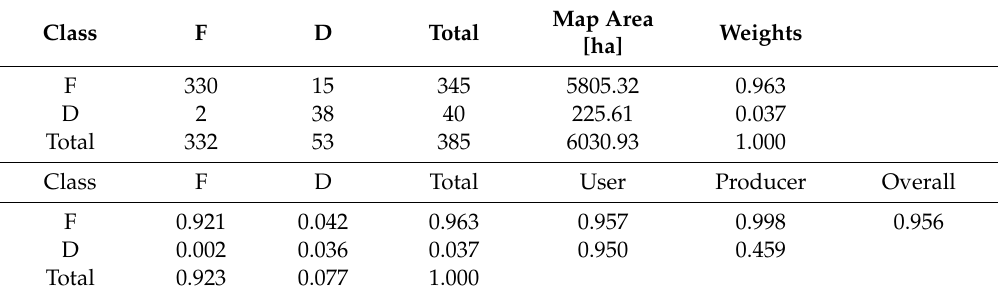
Table A6. “S1 Only” Peru disturbance method validation (only forest area).